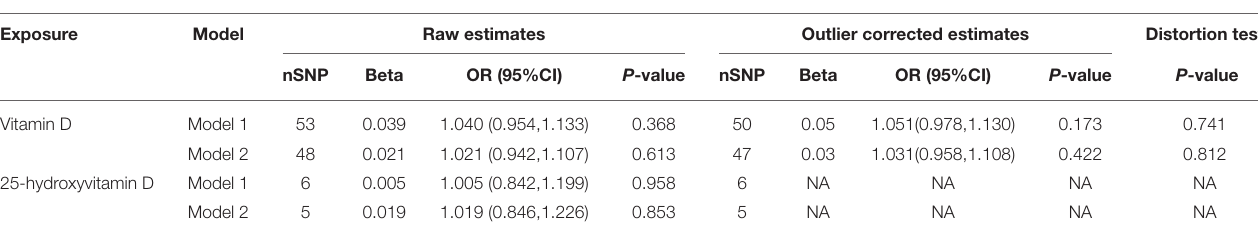
TABLE 2 | MR-PRESSO for causal effect between vitamin D and AF. Exposure Model Raw estimates Outlier corrected estimates Distortion test nSNP